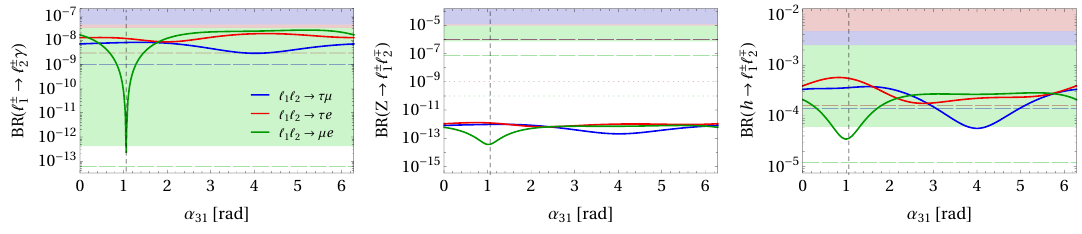
Figure 7 . The decay rates versus the Majorana phase α 31 ; all the other parameters are kept at their values of benchmark point 1 of table 3. The vertical dashed lines mark the value α of